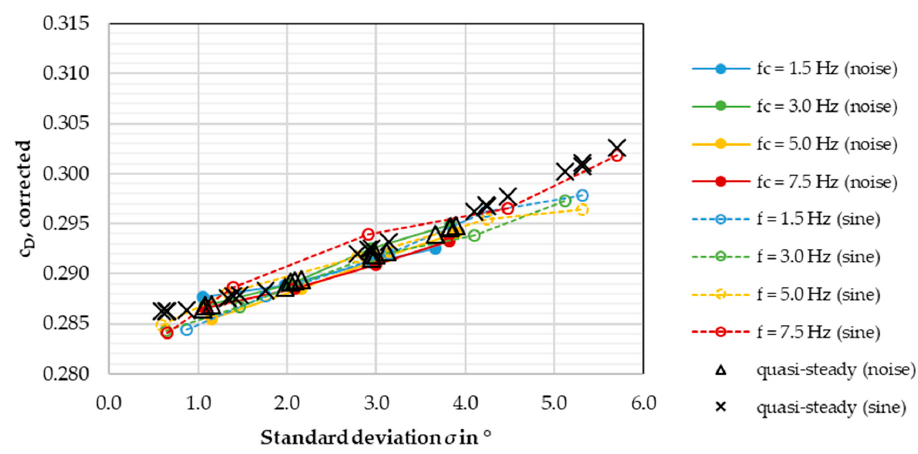
Figure 15. Corrected c D for the DrivAer notchback model, in one diagram, with quasi-steady drag.